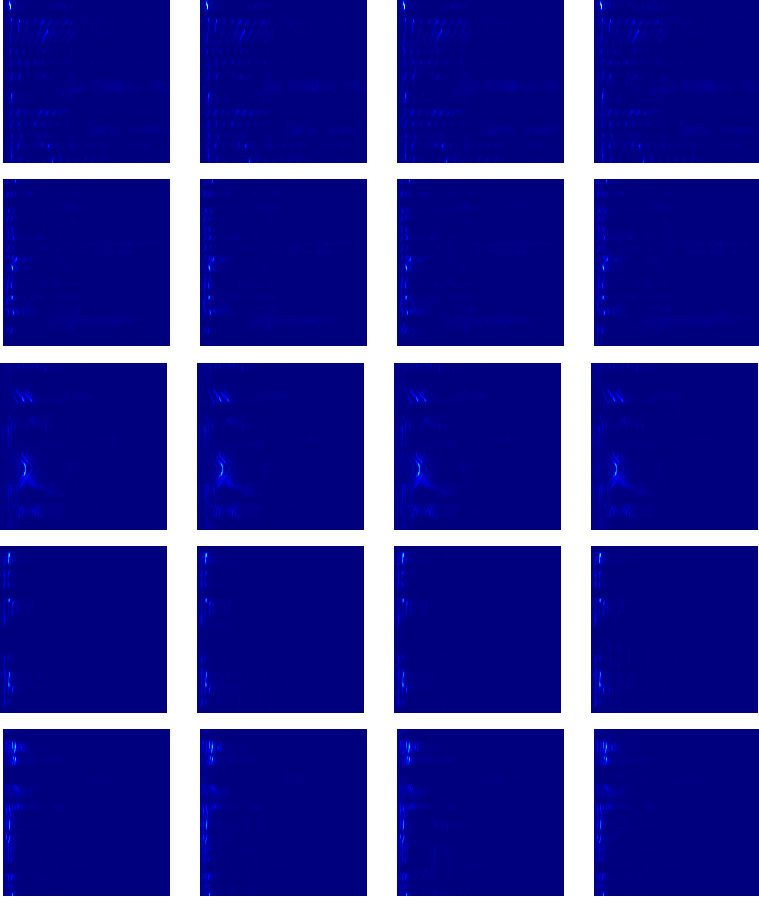
Figure 1. Examples of part of the augmentation process for an anger (first row), a fear (second row), a happiness (third row), a fear (fourth row) and a neutral (fifth row) sample. The augmentation process generates 3 new spectrorams by adding background noise at three different levels (4 augmentation results in overall). Figure is best viewed in